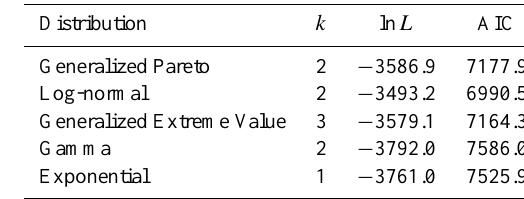
Table 4. The maximum values of the log-likelihood function (ln L ) and the corresponding values of the AIC for the model distribution functions considered to fit the rescaled distributions given in Fig. 5. k is the number of parameters for the considered